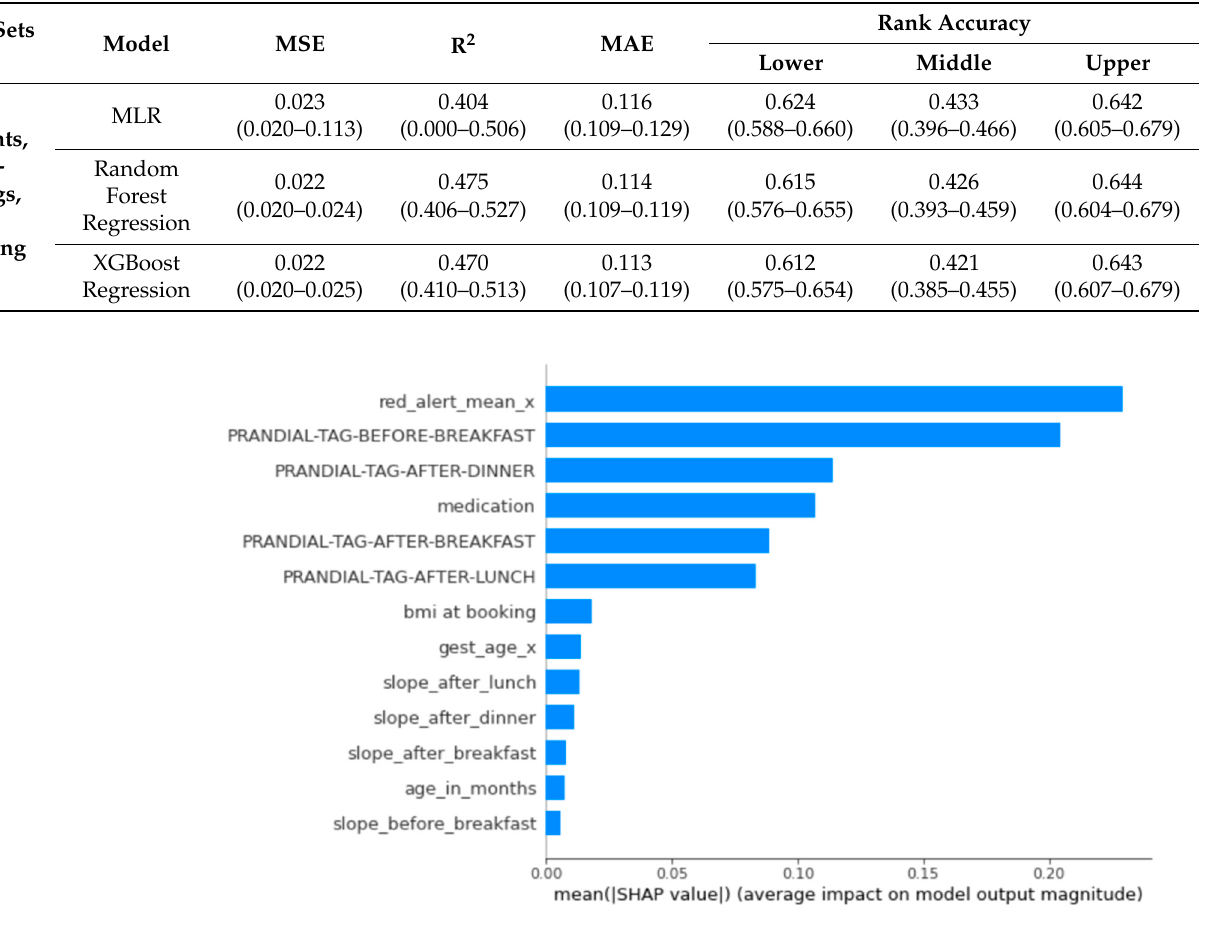
Figure A9. SHAP ranking for all features, including BMI, using reduced dataset (362 patients in training set, corresponding to 2500 windows in test set; 90 patients in testing, corresponding to 601 windows).